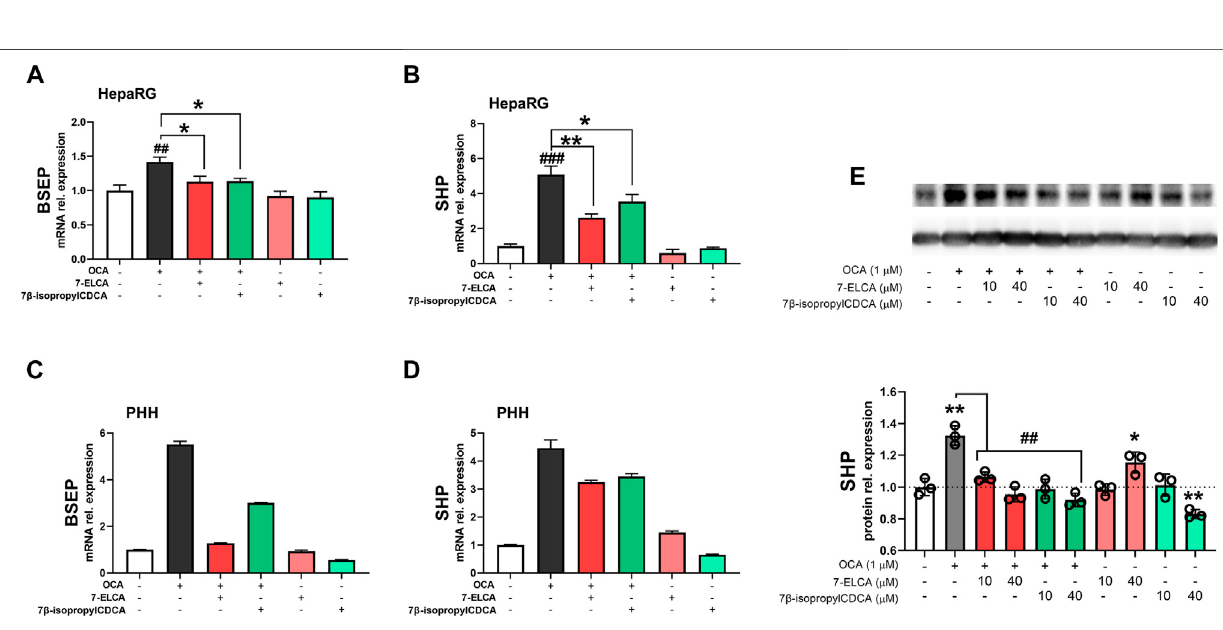
Frontiers in Pharmacology |